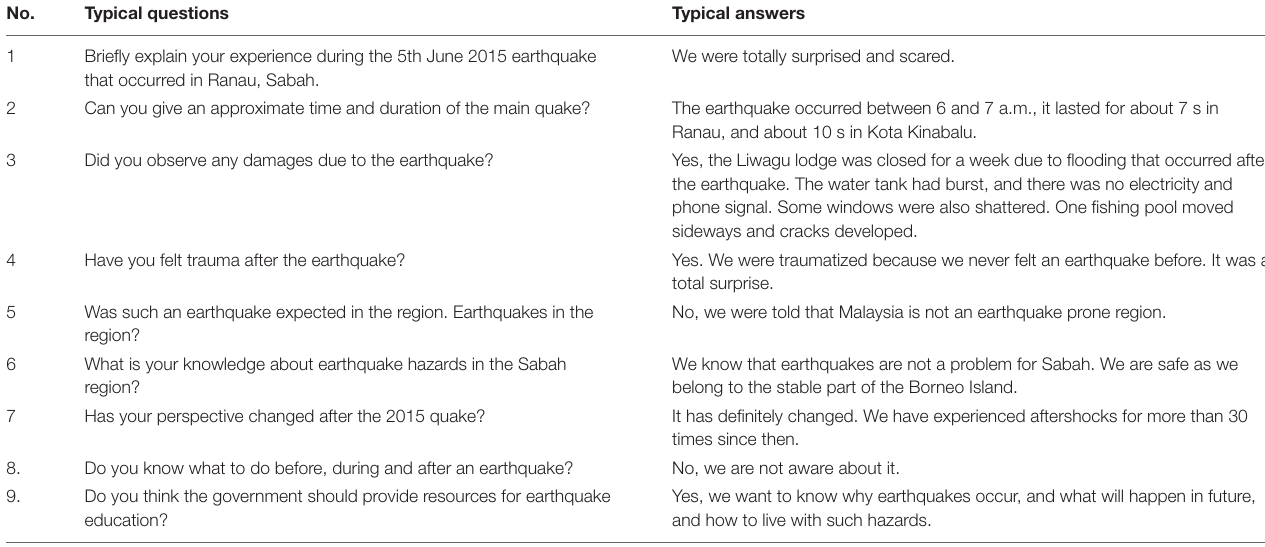
TABLE 1 | A typical questionnaire that was used to map the earthquake damage, education and awareness during the field interaction sessions with locals in Sabah, Malaysia.